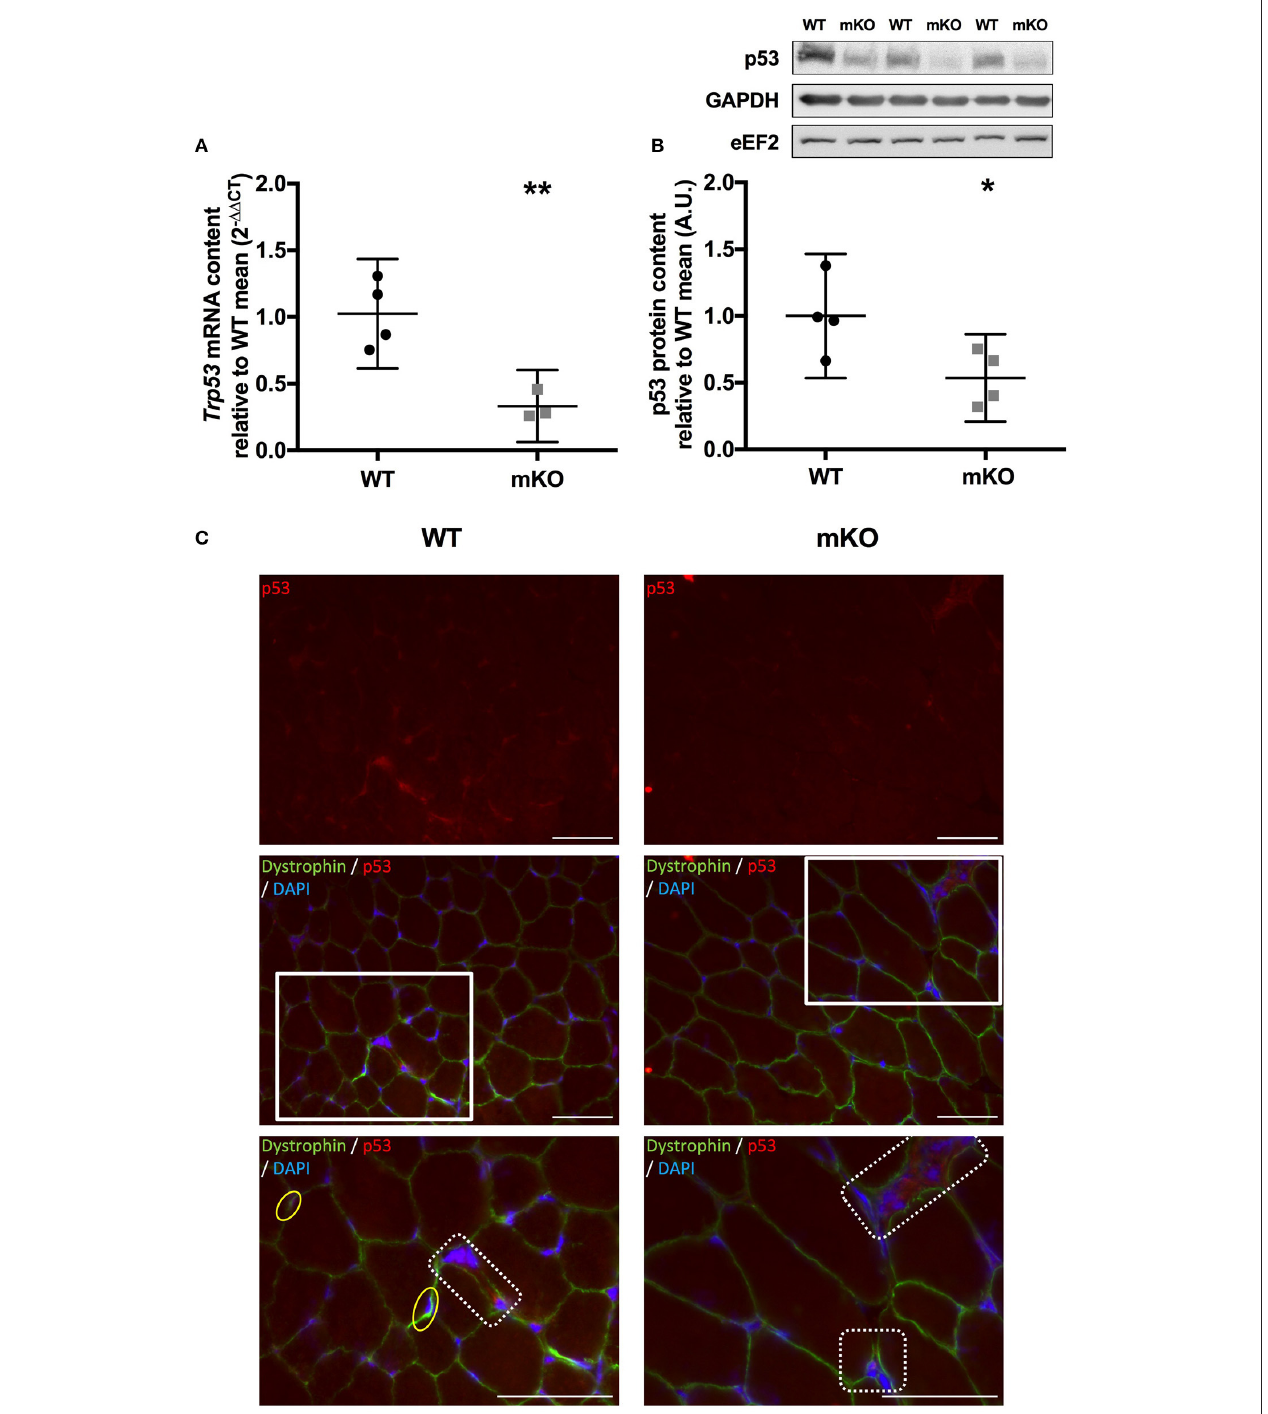
FIGURE 1 | Confirmation of p53 deletion in p53 mKO mouse model. (A) Reduction in Trp53 mRNA expression in quadriceps muscle of p53 mKO (grey squares) vs. WT (black circles) mice ( n = 3–4 per group). (B) Reduction in p53 protein content in triceps muscle of p53 mKO mice ( n = 4 per group). * p ≤ 0.05 mKO vs. WT; ** p ≤ 0.01 mKO vs. WT. (C) Representative immunofluorescence images for WT (left column) and mKO (right column) tibialis anterior muscle. The top row represents p53 only (red), the middle row shows a composite image of p53 (red), dystrophin (green), and dapi (blue), the third row shows an enlarged image of regions highlighted with a white box in the middle row. A reduction in overall staining can be seen in mKO compared to WT. Positive regions of p53 outside of the myofibre are apparent in both WT and mKO muscle and have been highlighted in dotted boxes in the third row. Myonuclei positive for p53 are apparent only in WT muscle and have been highlighted in yellow ovals in the third row. The scaling line in each image represents 50 µ M.